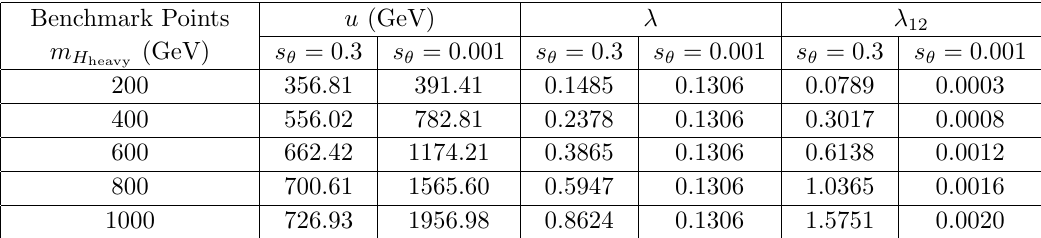
Table 3 . Values obtained for (cid:21) 1 = (cid:21) 2 = (cid:21) and vev u (in GeV) for some chosen heavy Higgs masses m H = 200, 400, 600 and 1000 GeV and two extreme values of mixing angles sin (cid:18) = heavy 0 : 3 (0 : 001) ; m h = 125 : 7 GeV and v = 246 SM